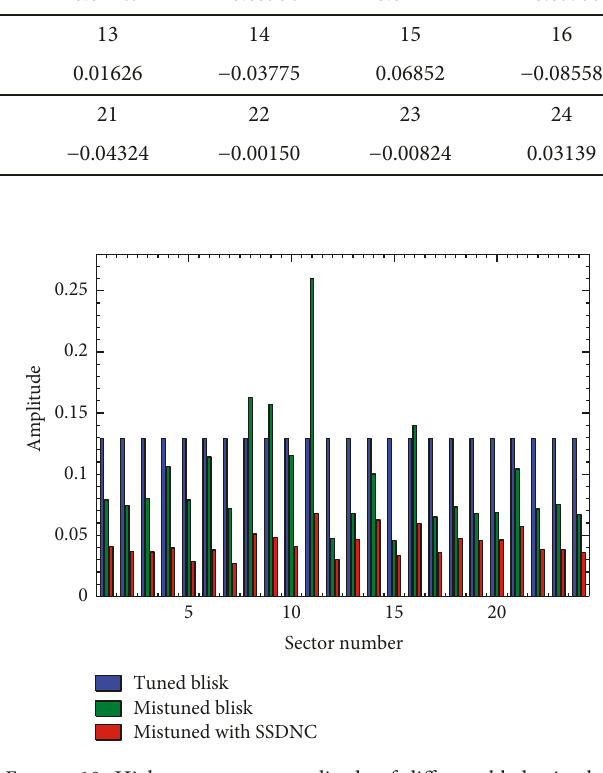
Figure 10: Highest response amplitude of di ff erent blades in the mistuned